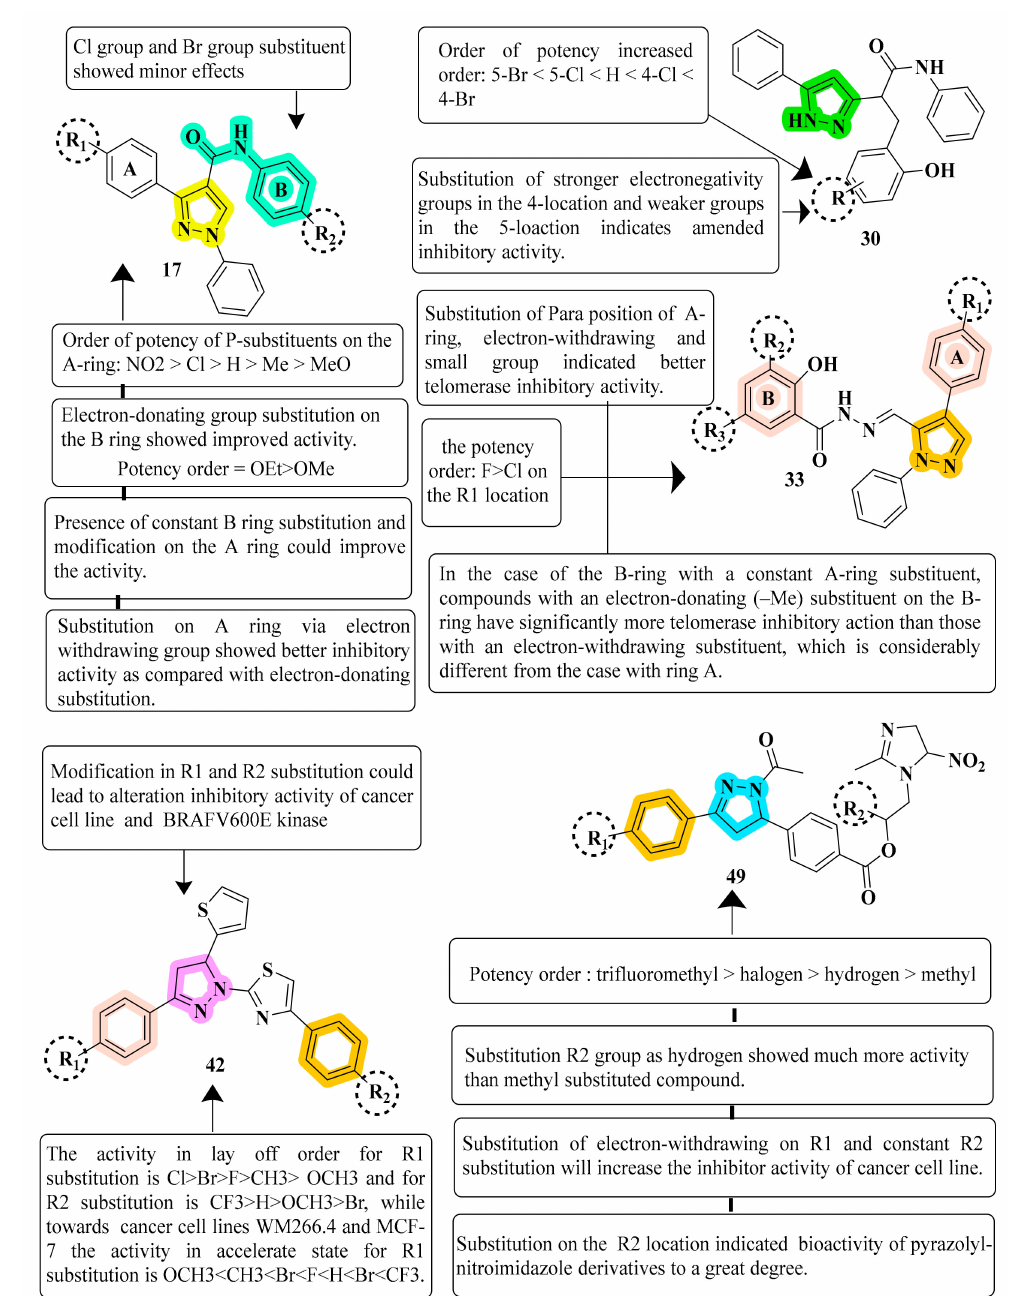
Figure 4. Structure and SAR of potent anticancer activity compounds 17 , 30 , 33 , 42 , and 49 . A series of novel BRAF-targeting pyrazole-based derivatives developed recently may prove useful against cancer. Some of them proved to have potential antitumor activity, par- ticularly compound 42 , which had an IC 50 value of 0.12 µ M against the cell line WM266.4 and 0.16 µ M against the cell line MCF-7 and which also showed the most potential antipro- liferative activity of apoptosis by flow cytometry experiments. Common scaffolds consist of a terminal aromatic group (phenyl or pyrazole) that fills the allosteric pocket. Thrio- phene and thiazole groups were demonstrated to have antibacterial, anti-inflammatory, and antiviral properties according to generalized research. The relevant compounds were formed by displacing the DFG loop and an amide linker and linking an aryl group in the hydrophobic pocket to a hinge-binding heterocycle. The introduction of an amide bond would enable the rapid and effective screening of different hinge-binding